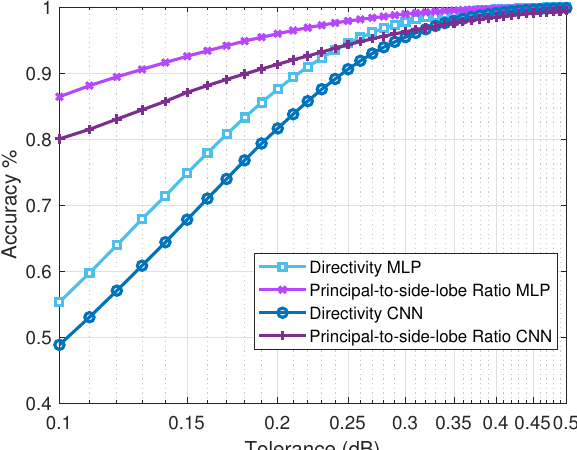
Figure 11. Accuracy vs tolerance in dB for both MLPNN and CNN. The curves shown correspond to Directivity and Principal-to-side-lobe Ratio.